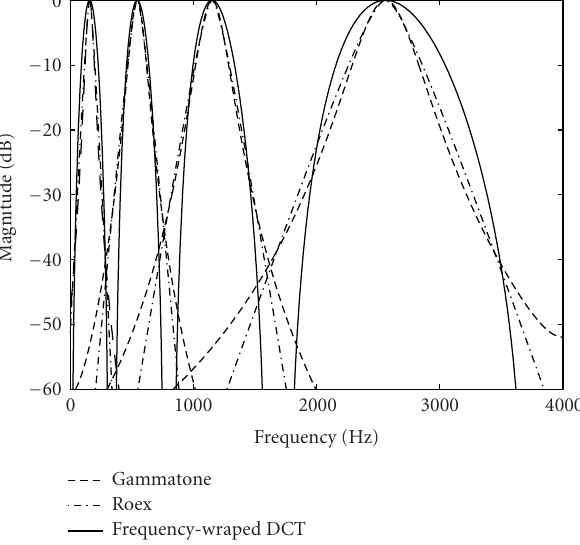
Figure 12: Phase function of the first-order allpass for four di ff erent values of the warping parameter λ . Figure 13: Normalized frequency responses of four channels of auditory filterbanks. Comparison between FIR gammatone filters, rounded exponentials, and a frequency-warped DCT-4 filterbank ( λ = 0 . 5, f s = 8kHz, 64-point Kaiser window with β =